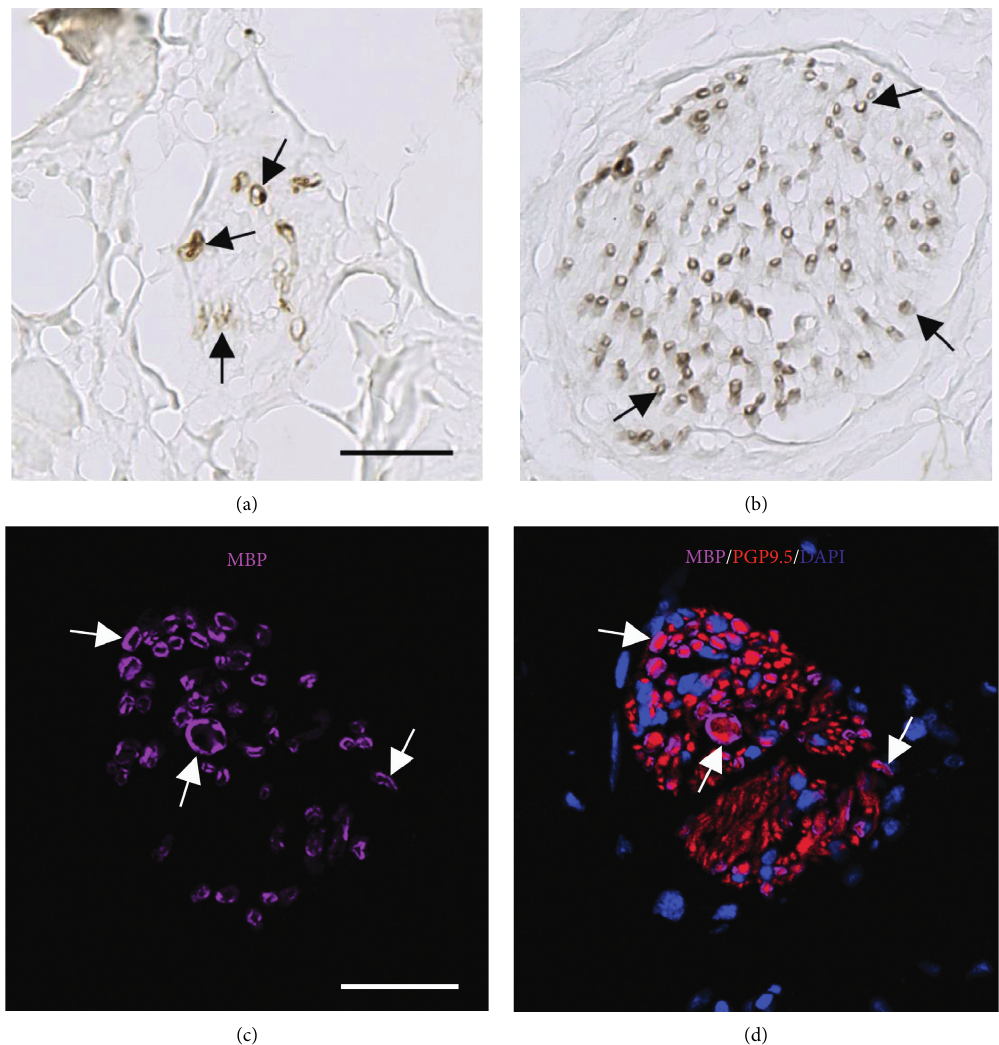
Figure 1: The myelin marker MBP surrounds axons in myocardial nerve bundles in the heart of rhesus macaques. Brightfield ((a, b); brown color) and fluorescent ((c, d); pink color) immunolabeling of MBP (arrows). MBP-immunoreactivity (-ir) surrounds a minority of PGP9.5- ir neuronal axons (red). Scale bars � 50 μ m. MBP, myelin basic protein; PGP9.5, protein gene product